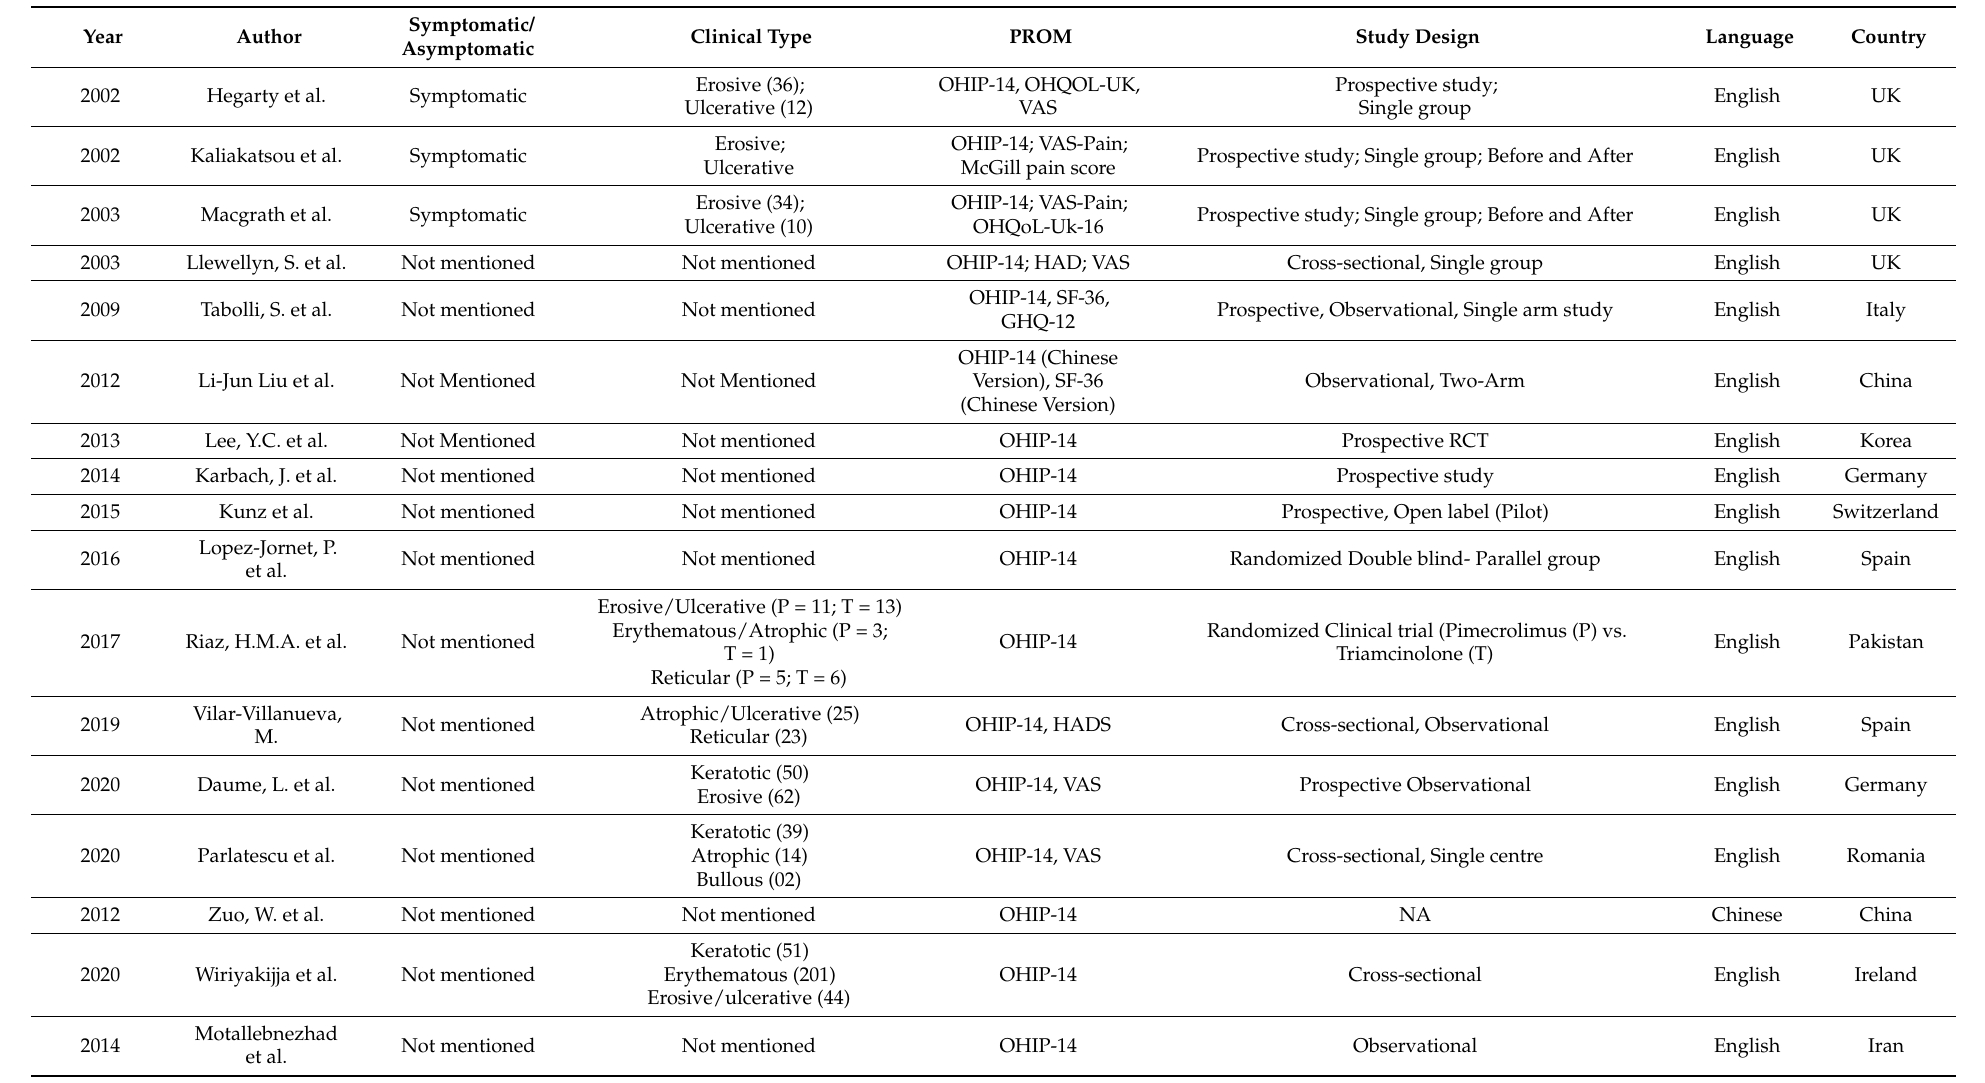
Table 1. Characteristics of the included studies that assessed Oral Health-Quality of Life associated with oral lichen planus using the Short-Form Oral Health Impact Profile